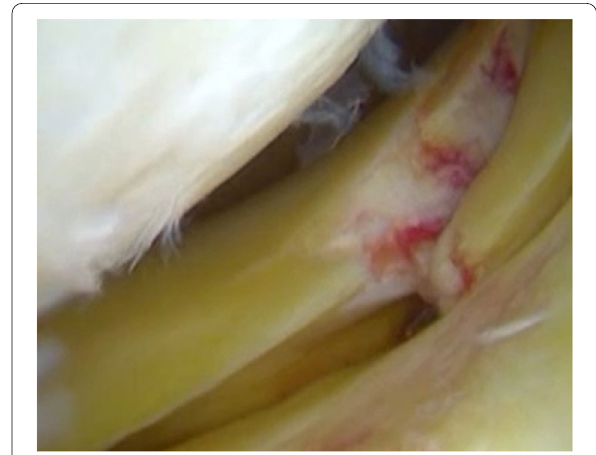
Fig. 2 Lateral posterior meniscus root lesion, which are reported to significantly increase the anterior tibial subluxation of the lateral compartment in patients with ACL injuries